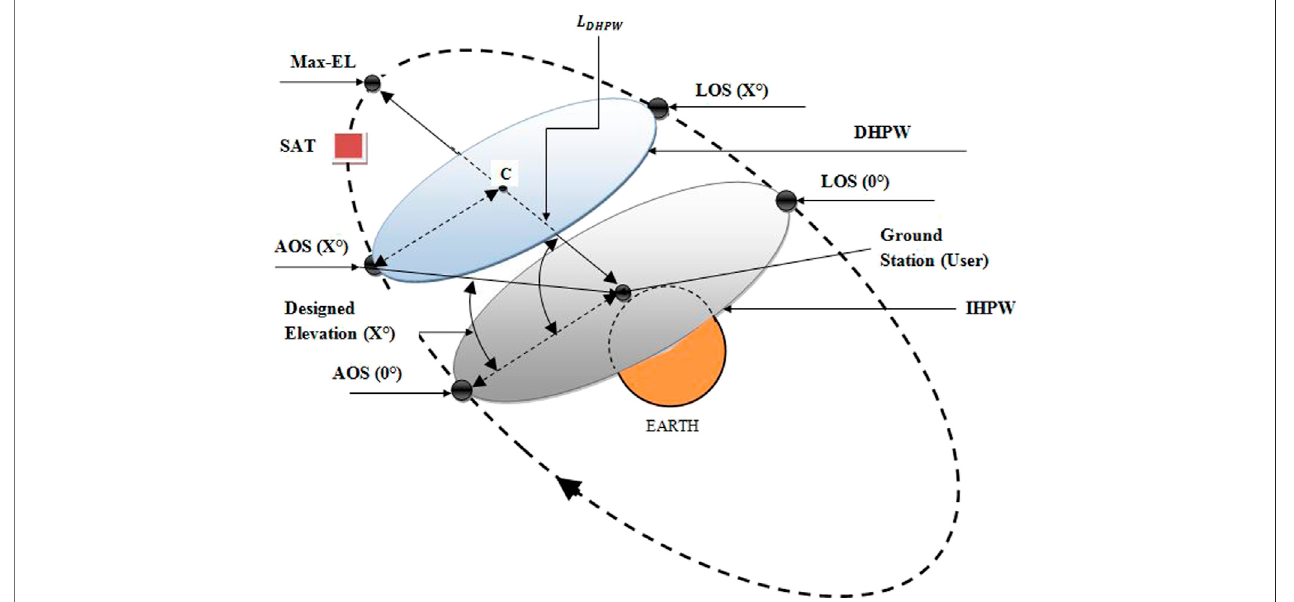
FIGURE 4 | Ideal and designed horizon